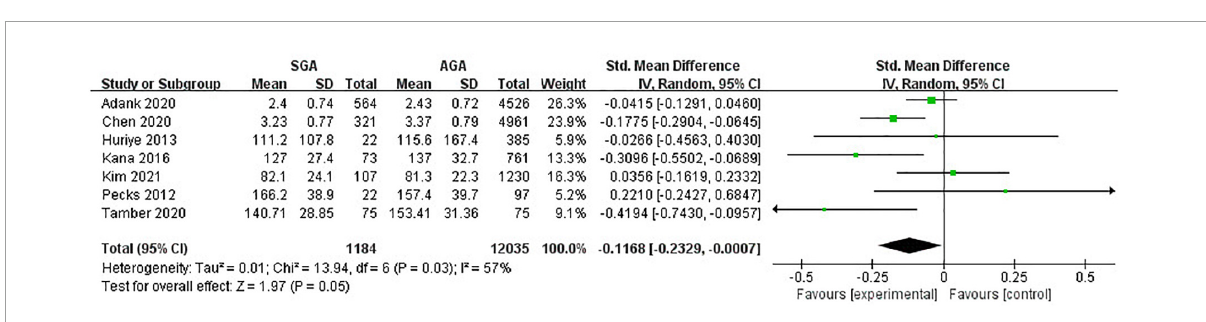
FIGURE4 Forest plot exploring the association between maternal TG levels and delivery of SGA. LDL-C, low-density lipoprotein-cholesterol; SGA, small for gestational